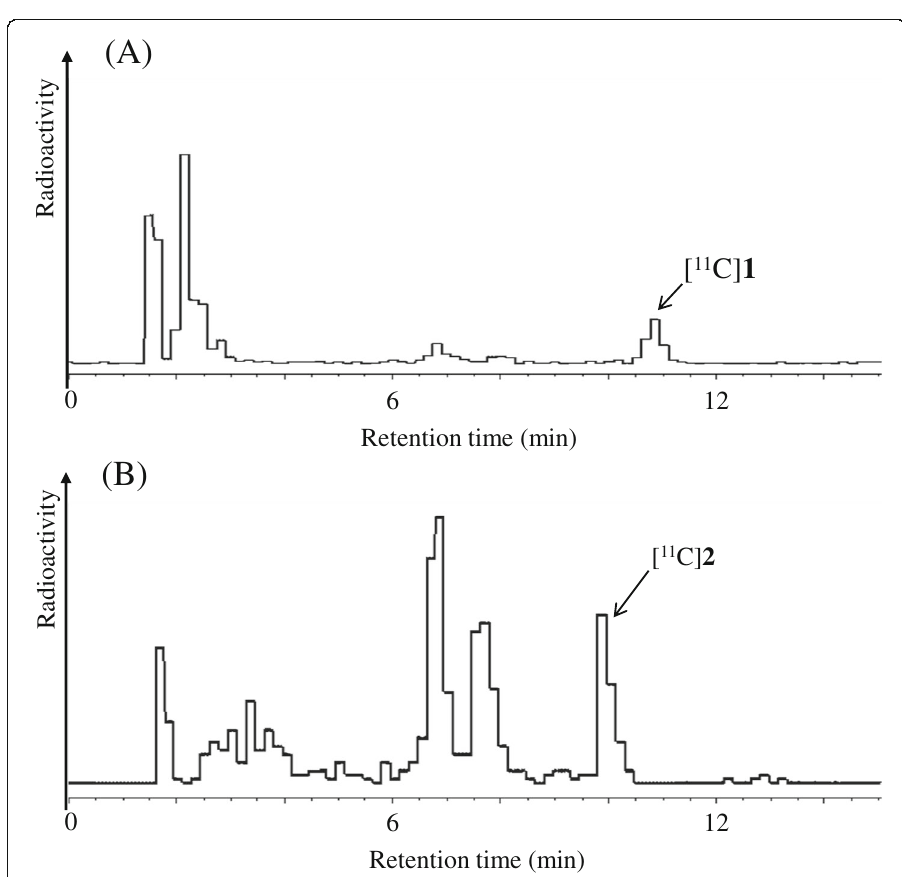
Fig. 3 Radio-HPLC chromatograms from metabolite analyses of mouse plasma at 30 min post-injection with [ 11 C] 1 (A) or [ 11 C] 2 (B). The injected dose of [ 11 C] 1 or [ 11 C] 2 were 37 – 56 MBq (0.73 – 0.95 nmol) or 46 – 61 MBq (1.1 – 1.5 nmol),